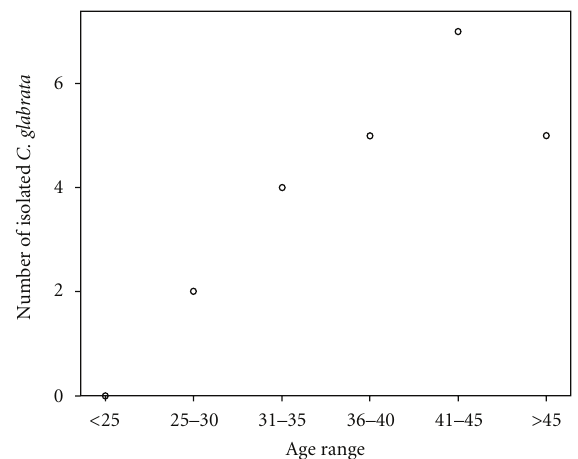
Figure 1: Correlation of participants’ age range and isolated C . glabrata .